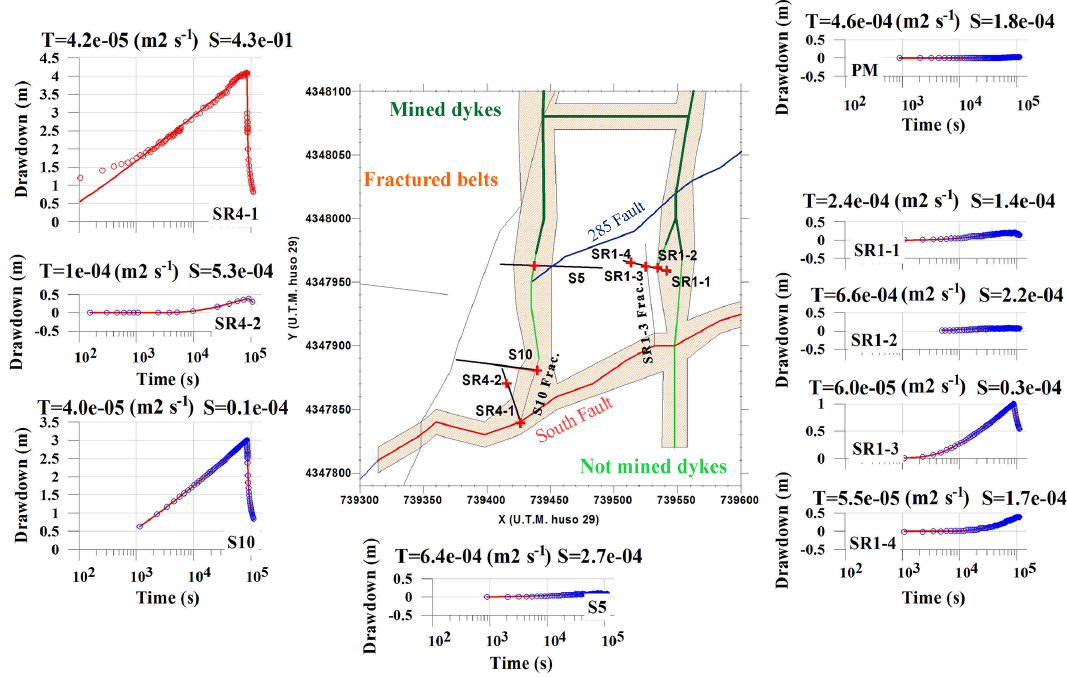
Figure 5. Results from preliminary interpretation of the South cross-hole test (pumping at SR4-1). Transmissivity and storativity are derived by fitting each borehole drawdowns, one at a time, using the Theis model. The degree of connectivity was derived from the estimates of storage coefficients. T varies from 4 to 64 × 10 − 5 m 2 s − 1 , while S ranges from 1 × 10 − 7 to 0.43. We take S estimates to reflect connectivity. A small S (fast response) implies a good hydraulic connection between pumping and observation wells. This suggests that the best connec- tions occur between the pumping interval and points S10 and SR1-3, while points S5 and SR1-2, and, especially mine well (point PM, Pozo Maestro), were damped by the mine influence (which behaves as a constant head boundary).